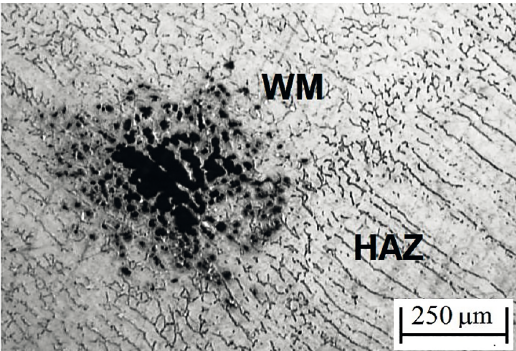
Figure 6. Preferential pitting corrosion in the weld metal after cyclic polarization test.